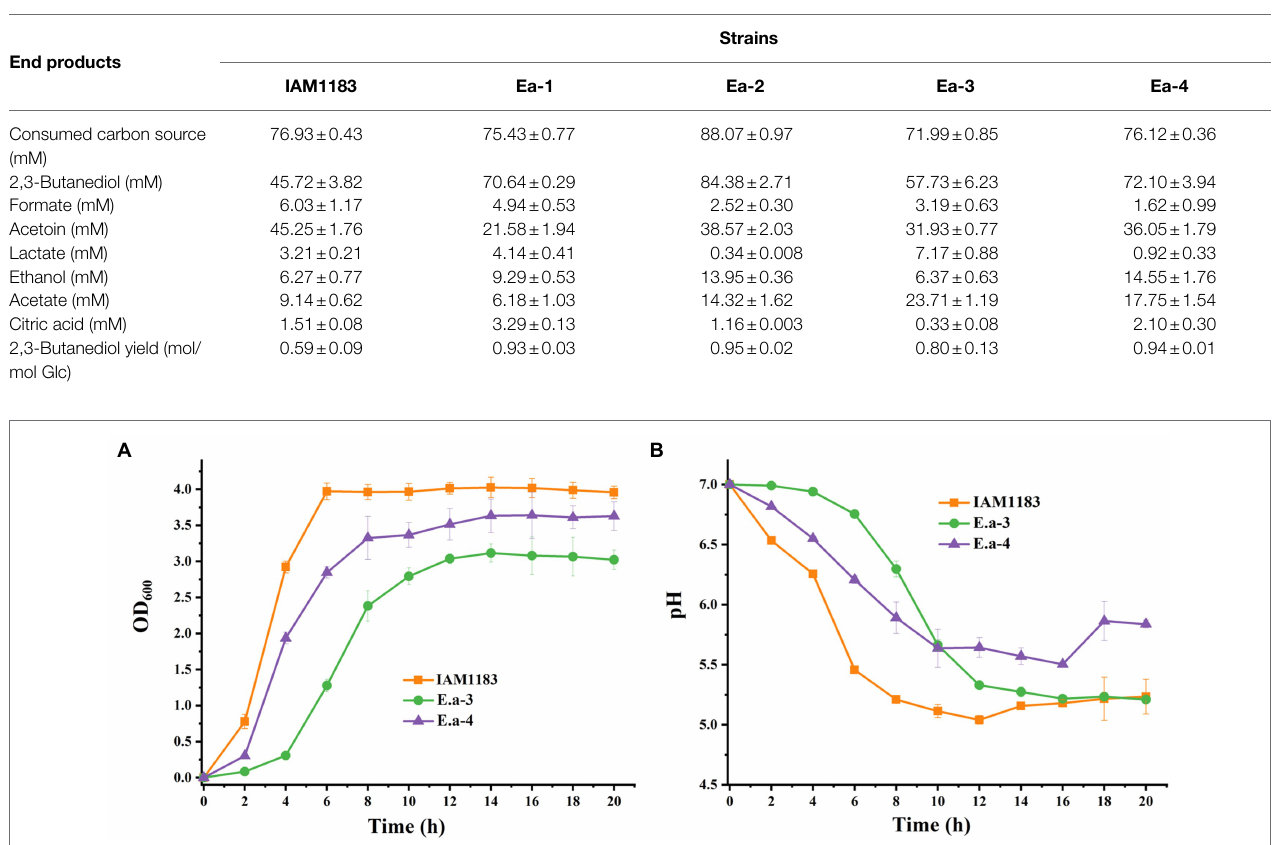
FIGURE 2 | Time-profiles of biomass accumulation (OD 600 ) and culture pH for IAM1183 and its mutants. (A) Biomass of IAM1183, Ea-3 and Ea-4. (B) Culture pH of IAM1183, Ea-3 and Ea-4 ( n =